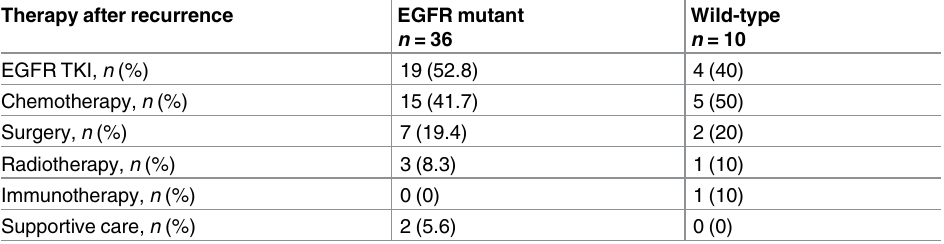
Table 3. Treatment modalities for recurrent disease.